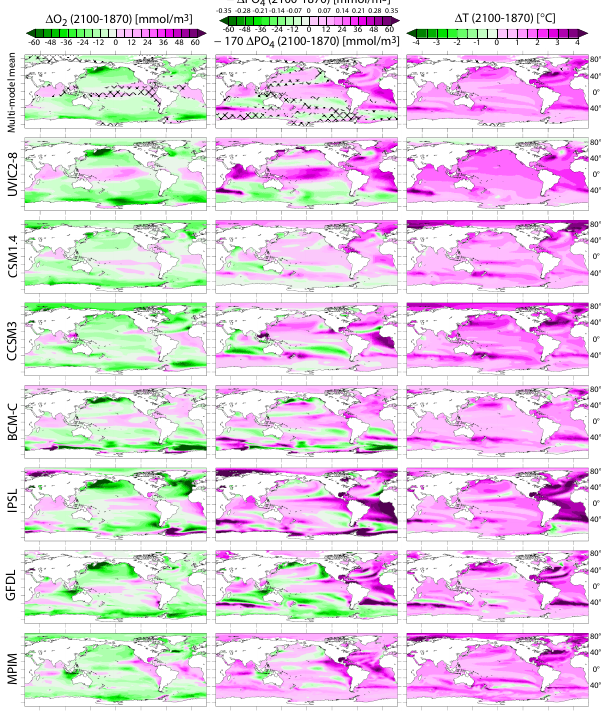
Fig. 6. Projected changes in f O 2 in the UML (100 to 600m depth) for the SRES A2 scenario. Changes are for 2100 relative to 1870. The multi-model mean is given in the upper left panel; hatched areas indicate where less than five out of seven models agree in the sign of the projected